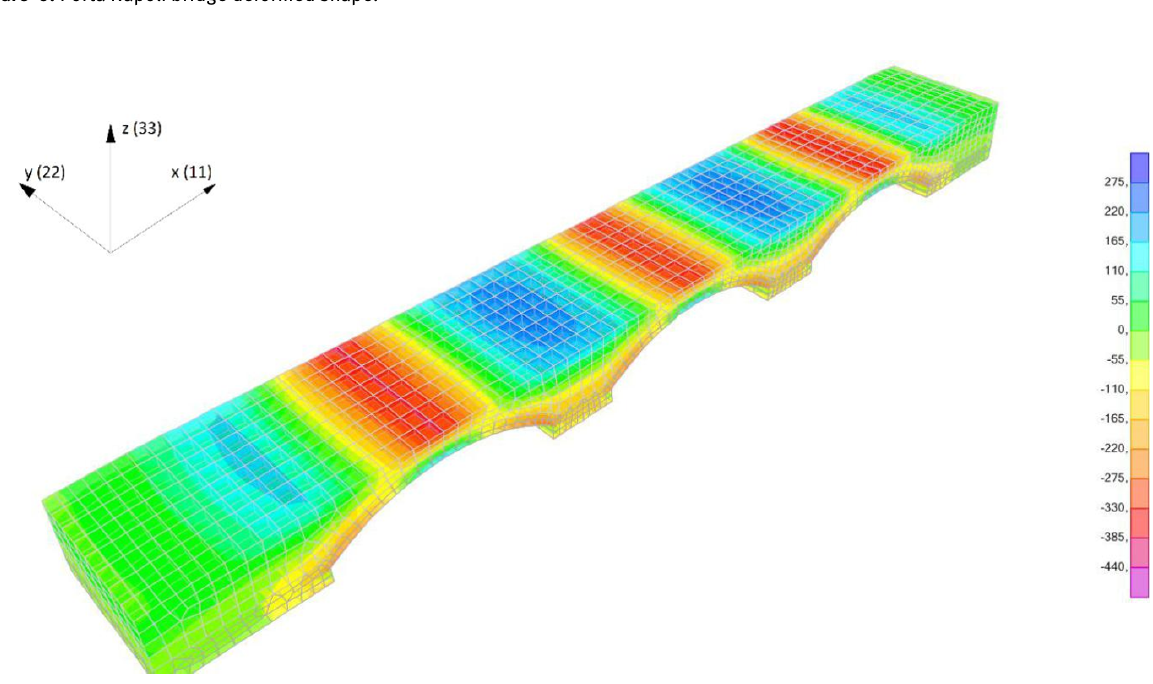
Figure 7: Porta Napoli bridge principal stress contour.